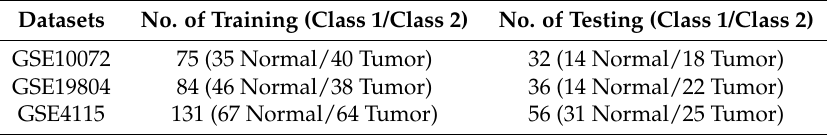
Table 2. Detailed information of the three publicly available datasets used in the